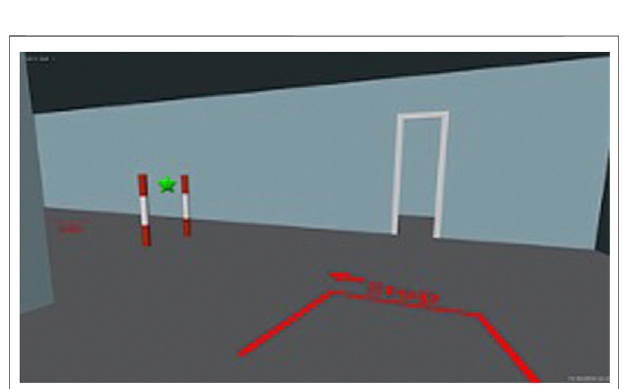
FIGURE 8 | Alshaer et al. (2017) did not tell participants about the passability of the doorframes or gaps to preserve realism. Furnishings or decorations were excluded to avoid distractions.